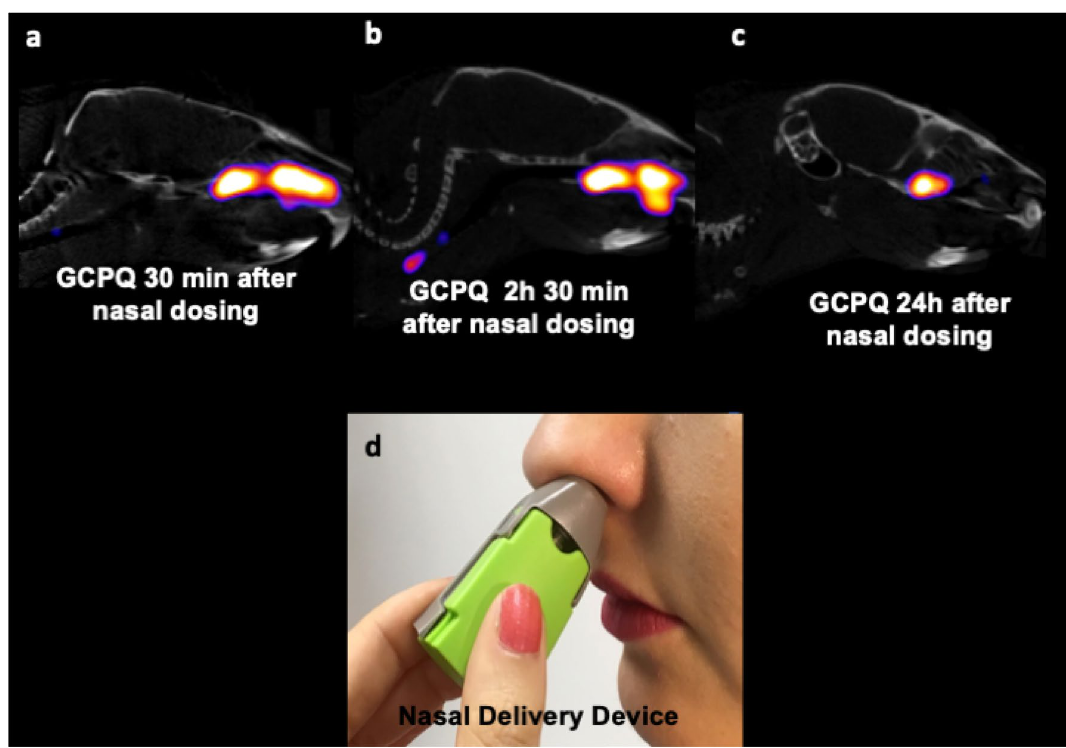
Figure 5. Sagittal SPECT/CT images of radiolabelled GCPQ (10 mg/kg) at 30 min, 2 h 30 min and 24 h after nasal administration to male mice ( a – c ), the nasal delivery device (Naltos device) that may be used to deliver the prophylactic GCPQ powder, permission from Alchemy Pharmatech Ltd. ( d